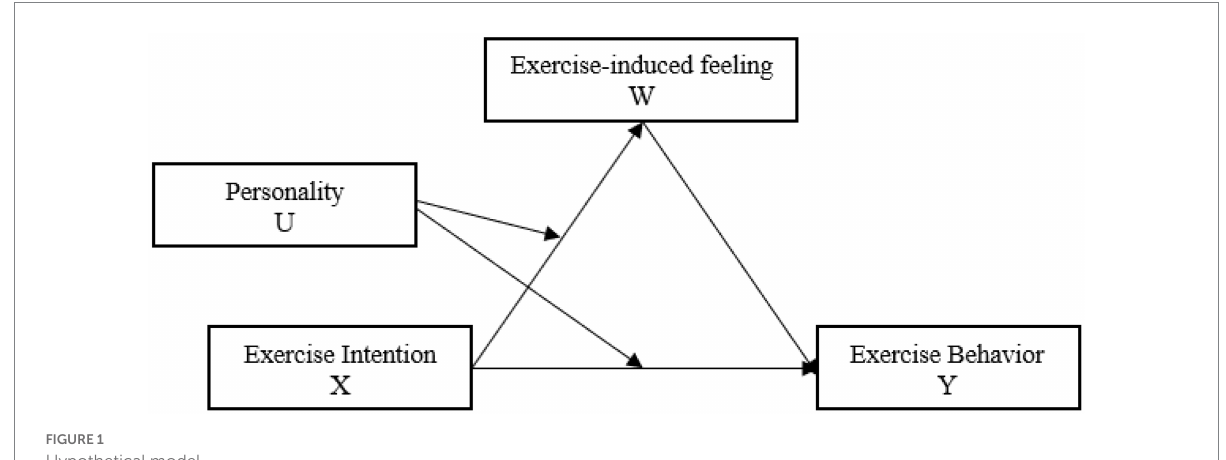
FIGURE 1 Hypothetical model.